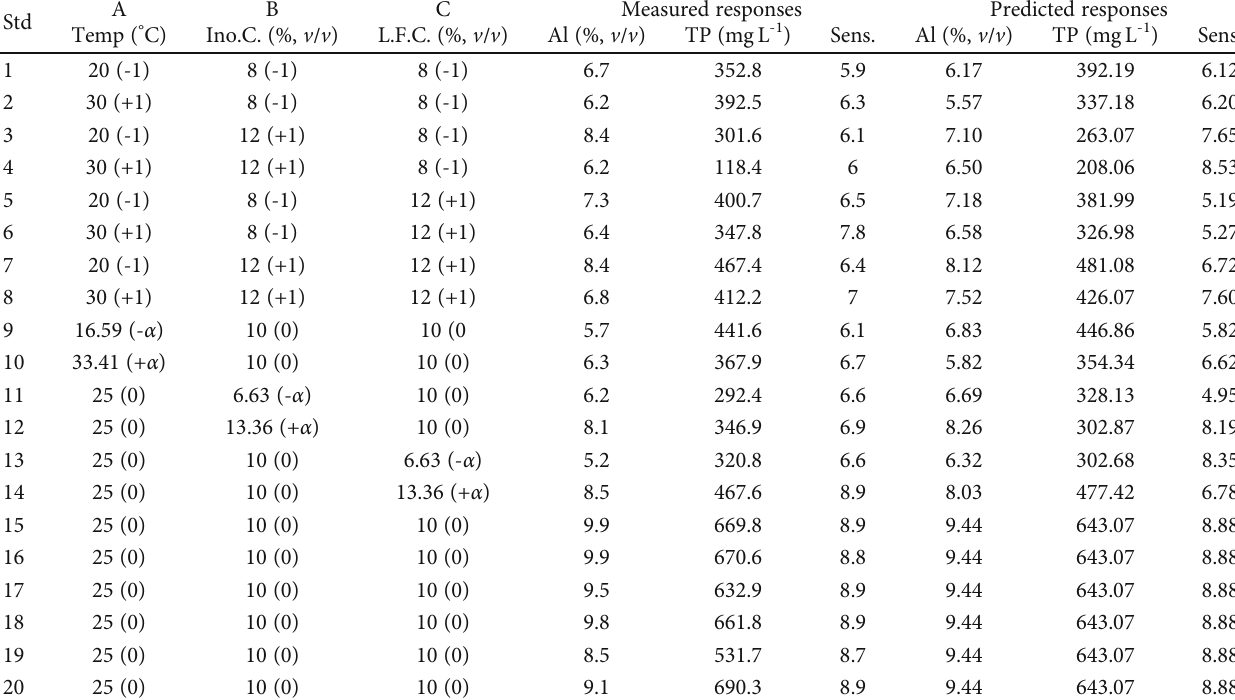
Table 4: CCRD of three variables with the observed responses and predicted values for all